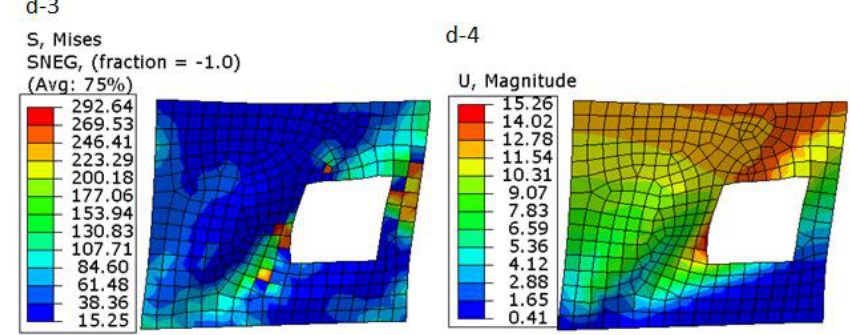
Figure 15. Von Mises stress and displacement for concrete part (d-3) stress and (d-4) displacement.